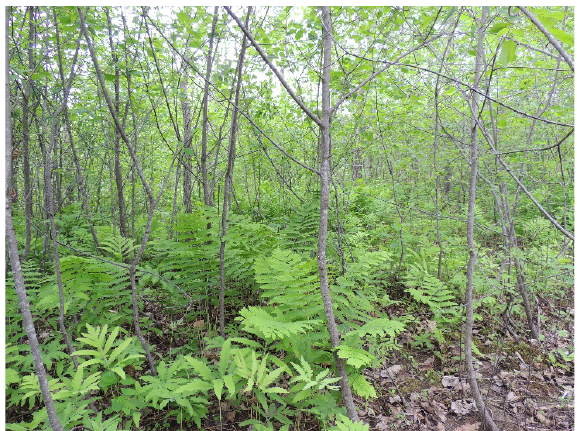
Figure 6. Arborescent architecture of glossy buckthorn in plantation understory.